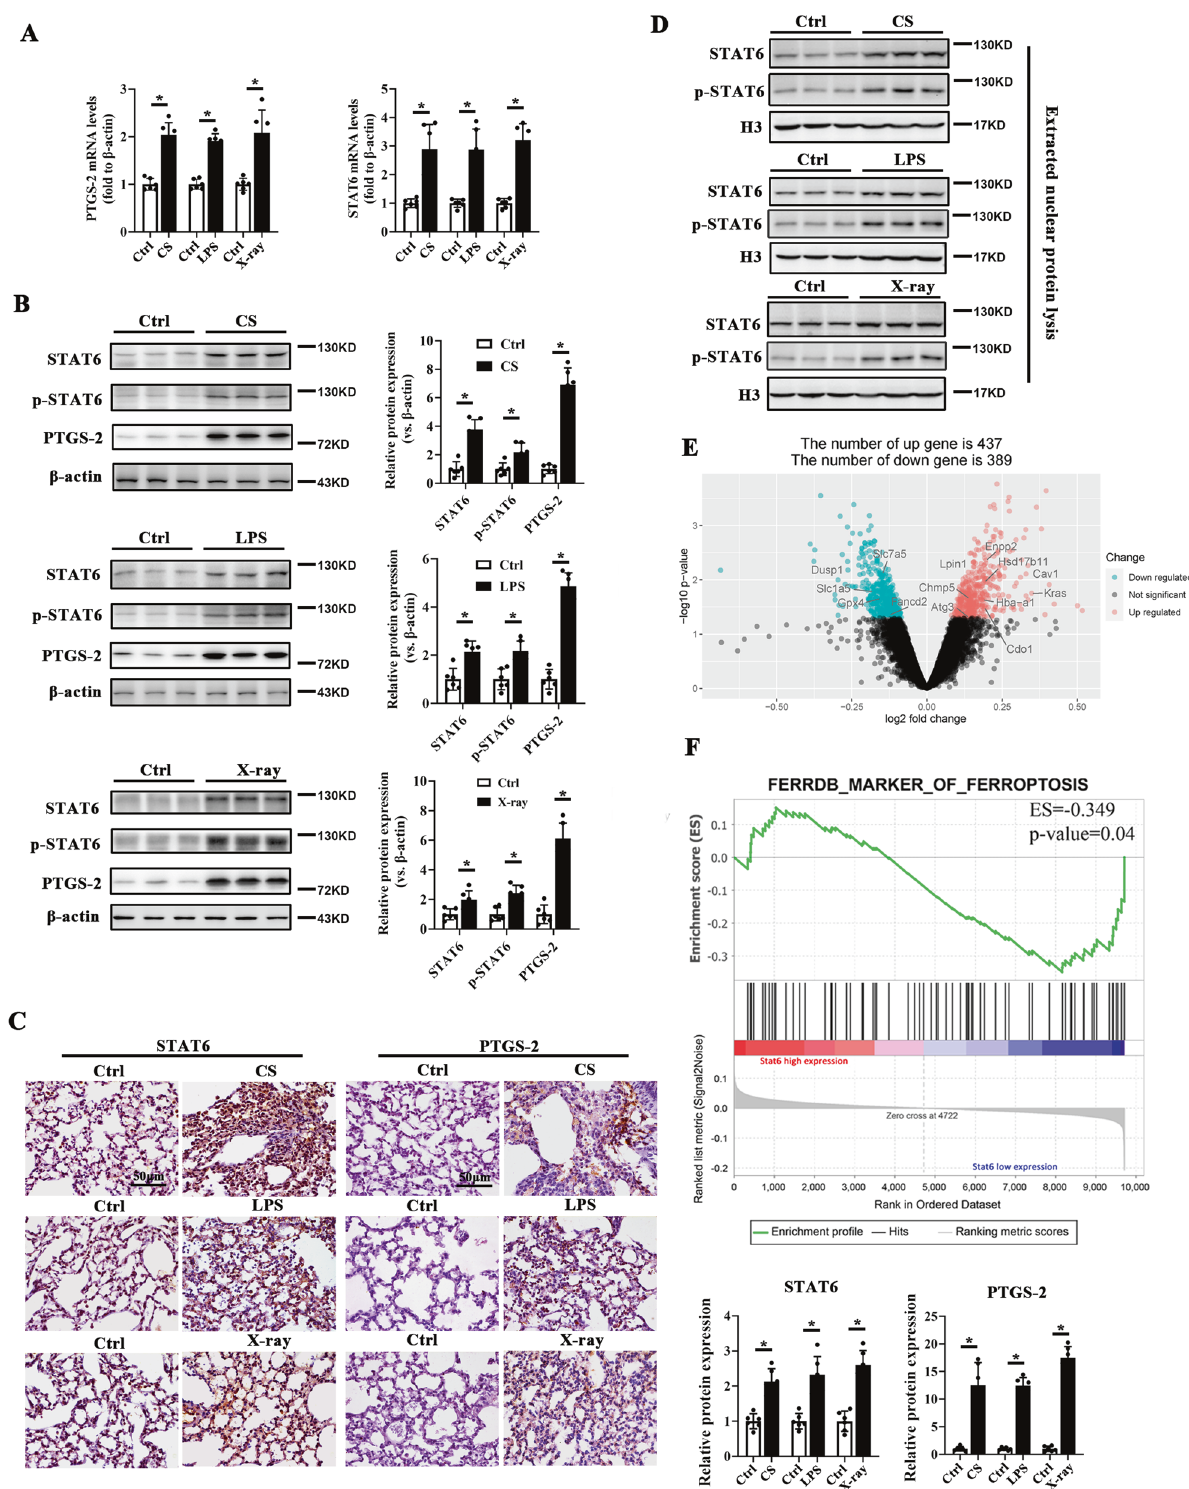
Fig. 1 STAT6 is activated in CS, LPS and X-ray induced ferroptosis of acute lung injury. A The mRNA levels of PTGS-2 and STAT6 in indicated mice lung tissue were determined by qRT-PCR. B Lung tissue lysates from indicated group of mice were subjected to immunoblot analysis with the quanti fi cation on the right panel. C Representative photographs showed STAT6 and PTGS-2 staining in lung tissue from indicated groups. D The expression of STAT6 in indicated extracted nuclear protein. E Volcano plot showed differential expressed genes in rats with high and low Stat6 expression with ferroptosis-related genes labeled. F GSEA plot showed enrichment of “ marker of ferroptosis ” in STAT6 low expression group of rat. Data were expressed as means ± SD ( n = 6, * p < 0.05, Ctrl vs . treatment).